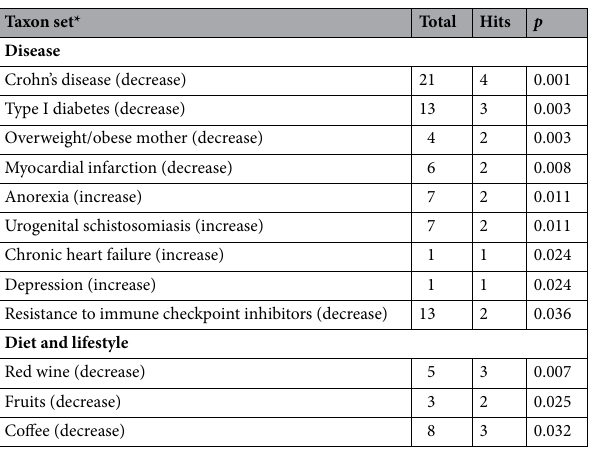
Table 2. Results of taxon set enrichment analysis (TSEA) showing taxon set, total taxa in each set, taxa sequenced, and associated p values for the food insecurity group. *Taxon sets analyzed as